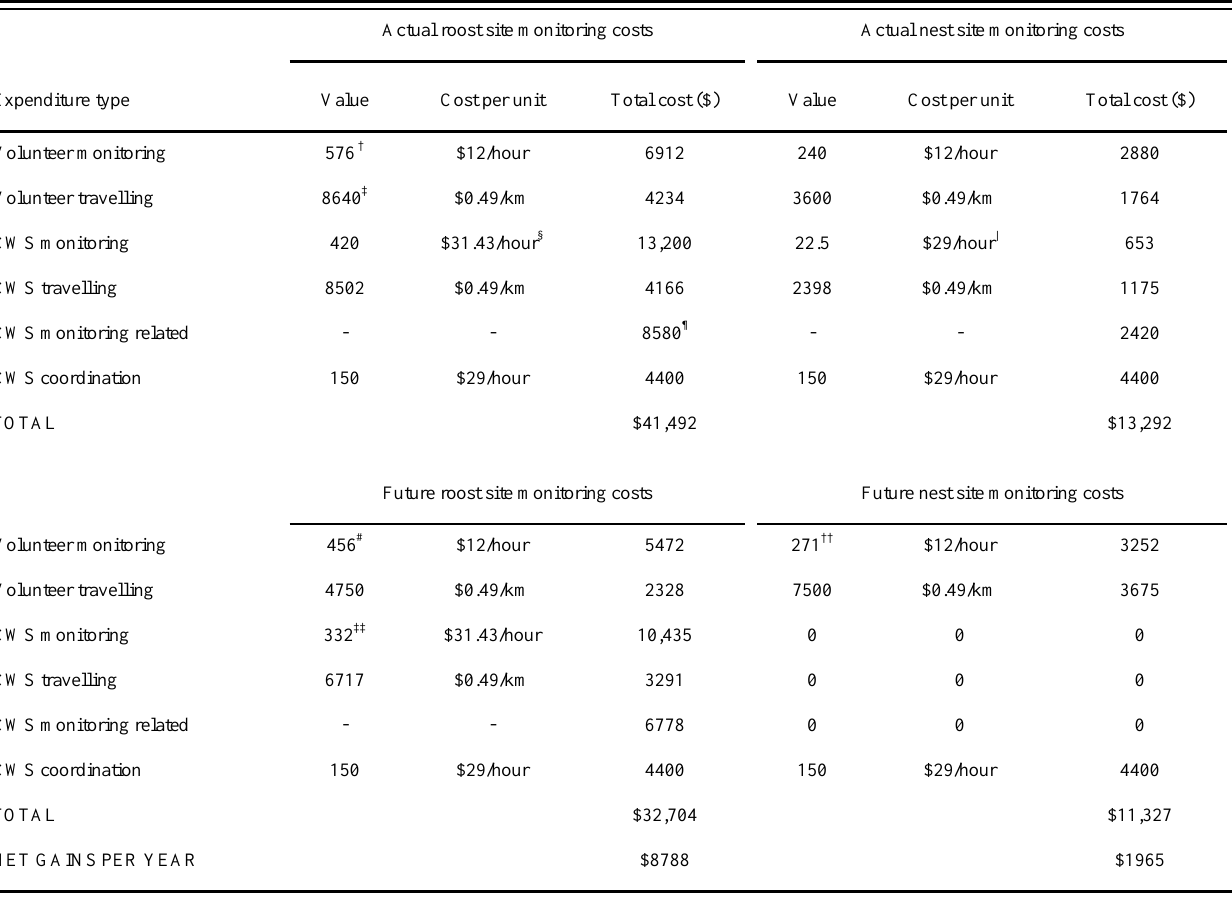
Table 3. Cost-benefit analysis of the modification of the Québec Chimney Swift Monitoring Program according to Nichols and Williams (2006)